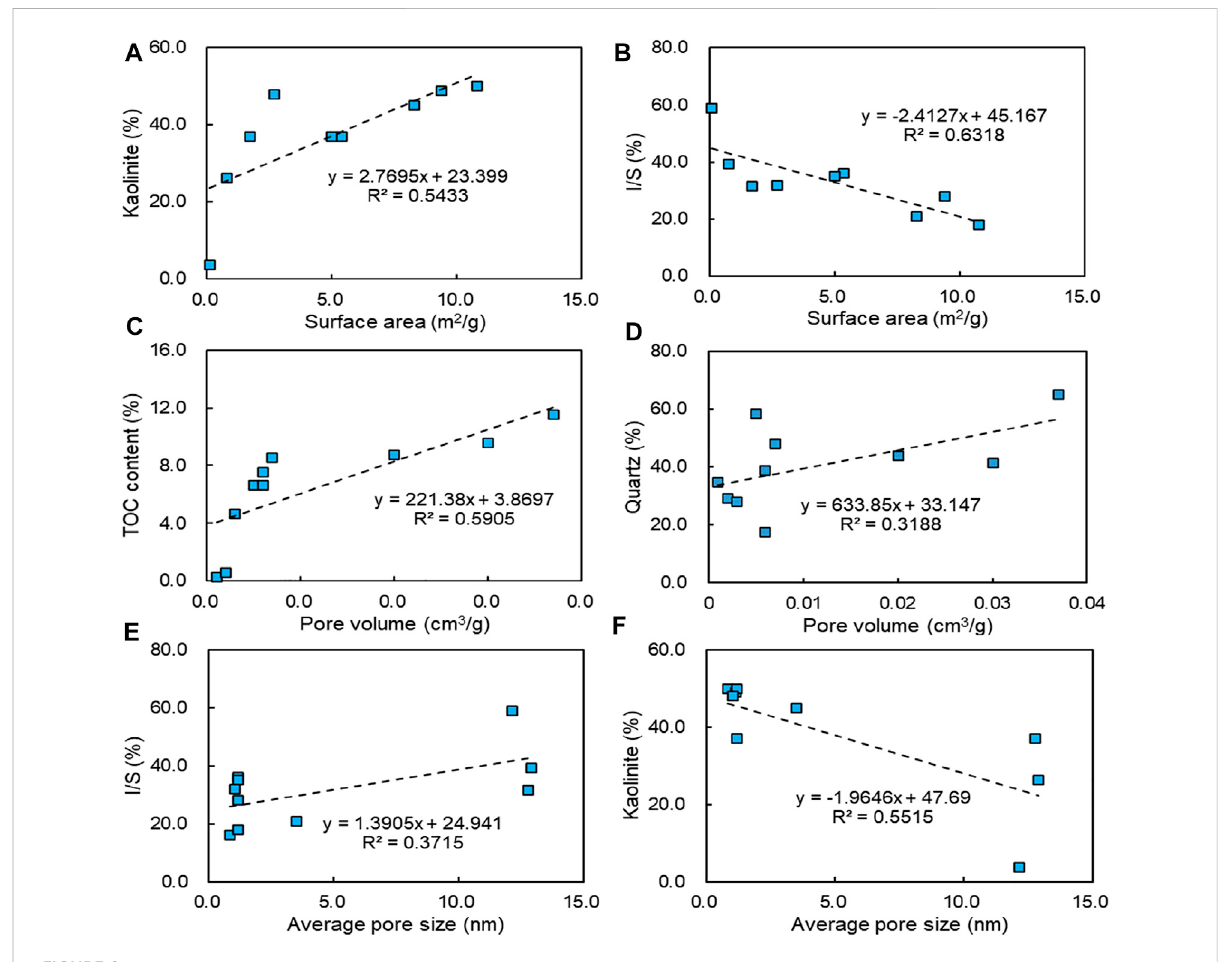
FIGURE 9 Pore structure parameters versus shale